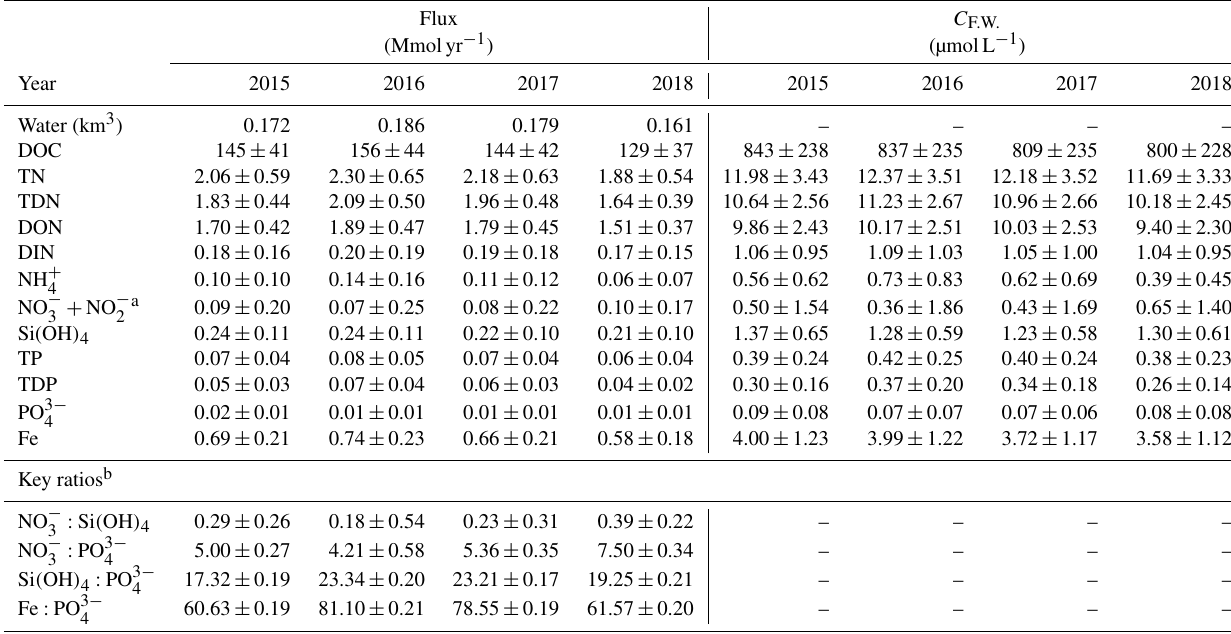
Table 1. Annual combined fluxes of nutrients from the seven gauged watersheds (46.9km 2 ), upscaled to the drainage area of the Kwakshua